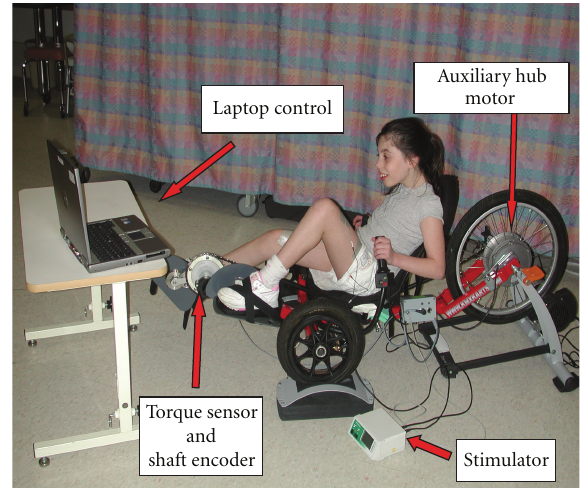
Figure 1: Tricycle components and participant set-up for FES-as- sisted cycling study [24]. The tricycle-based system is instrumented with a torque sensor and shaft encoder to allow for collection of torque, crank position and cadence, and consequentially the cal- culation of instantaneous power output, during the cycling session. The stimulator provides surface stimulation to bilateral quadriceps. The auxiliary hub motor was used for subjects 3 and 4 (please see text for details). A laptop computer is used for data acquisition, control of the stimulation timing, and control of the hub motor and to provide visual feedback on cycling performance to the